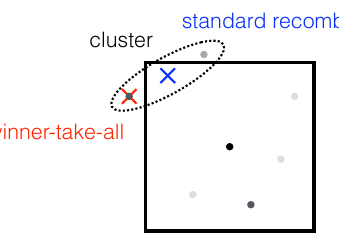
Figure 3 . The standard recombination scheme allows particles outside a pixel to be clustered into a pixel (blue), without being clustered with the pixel. This is not the case for the winner-take-all scheme